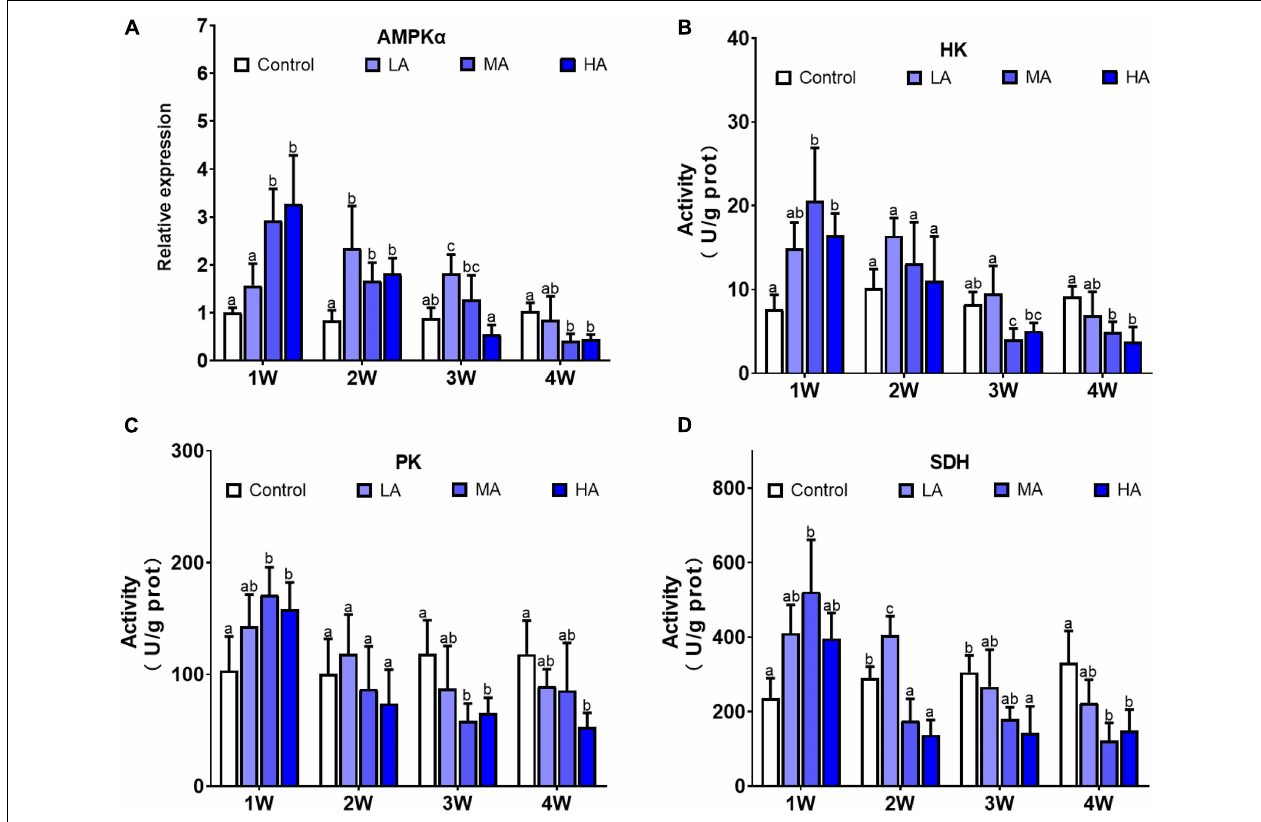
FIGURE 1 | Expression of AMPK α (A) and activities of HK (B) , PK (C) , and SDH (D) in different treatments during long-term ammonia stress. Values are means ± S.D ( n = 3). Different letters represent significant differences among different groups ( P < 0.05).